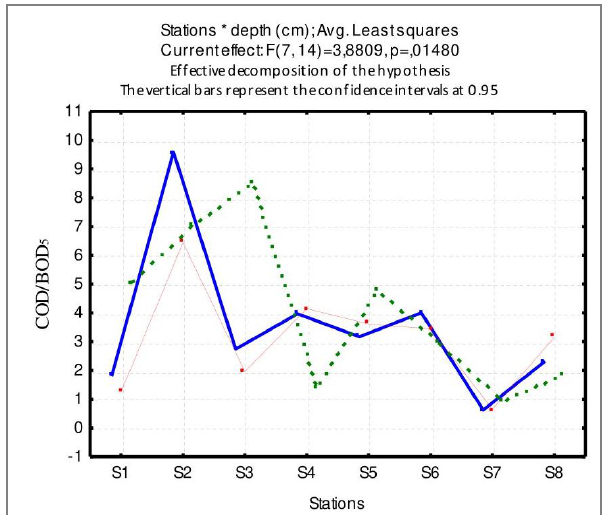
Figure 7. Spatial variation of COD / BOD5 In the lake of Reghaia